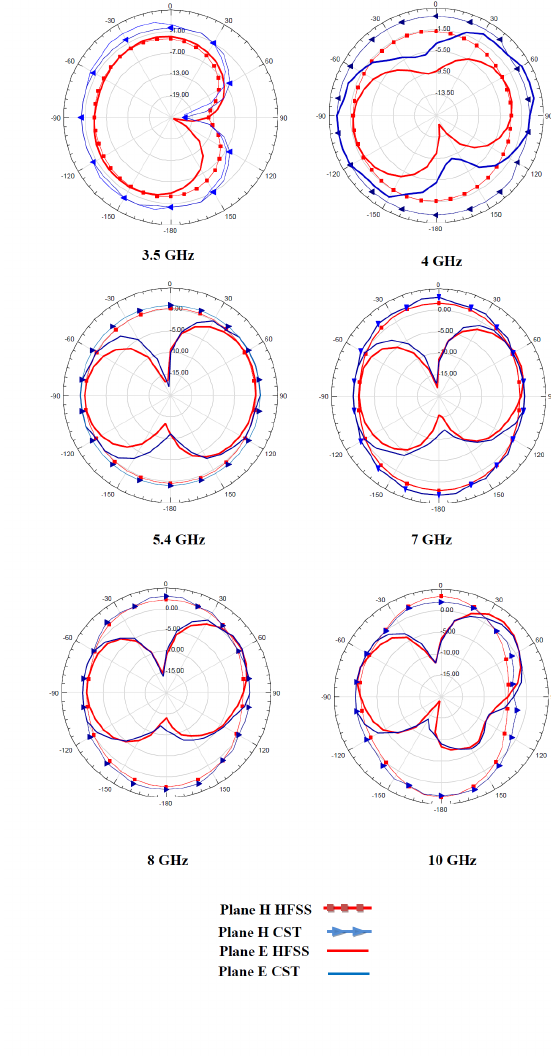
Figure 12: CST and HFSS Simulated directivity patterns in the H plane (y-z) and E plane (x-y) for the proposed